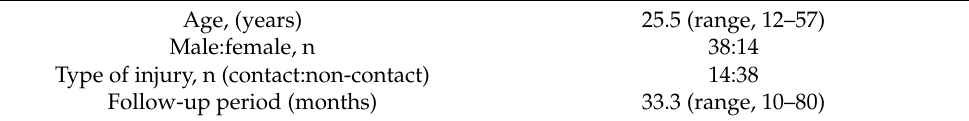
Table 1. Demographics of patients.